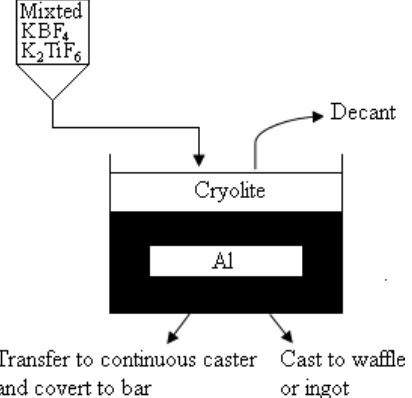
Figure 1: A schematic illustration of mixed salts in-situ reaction process (LSM